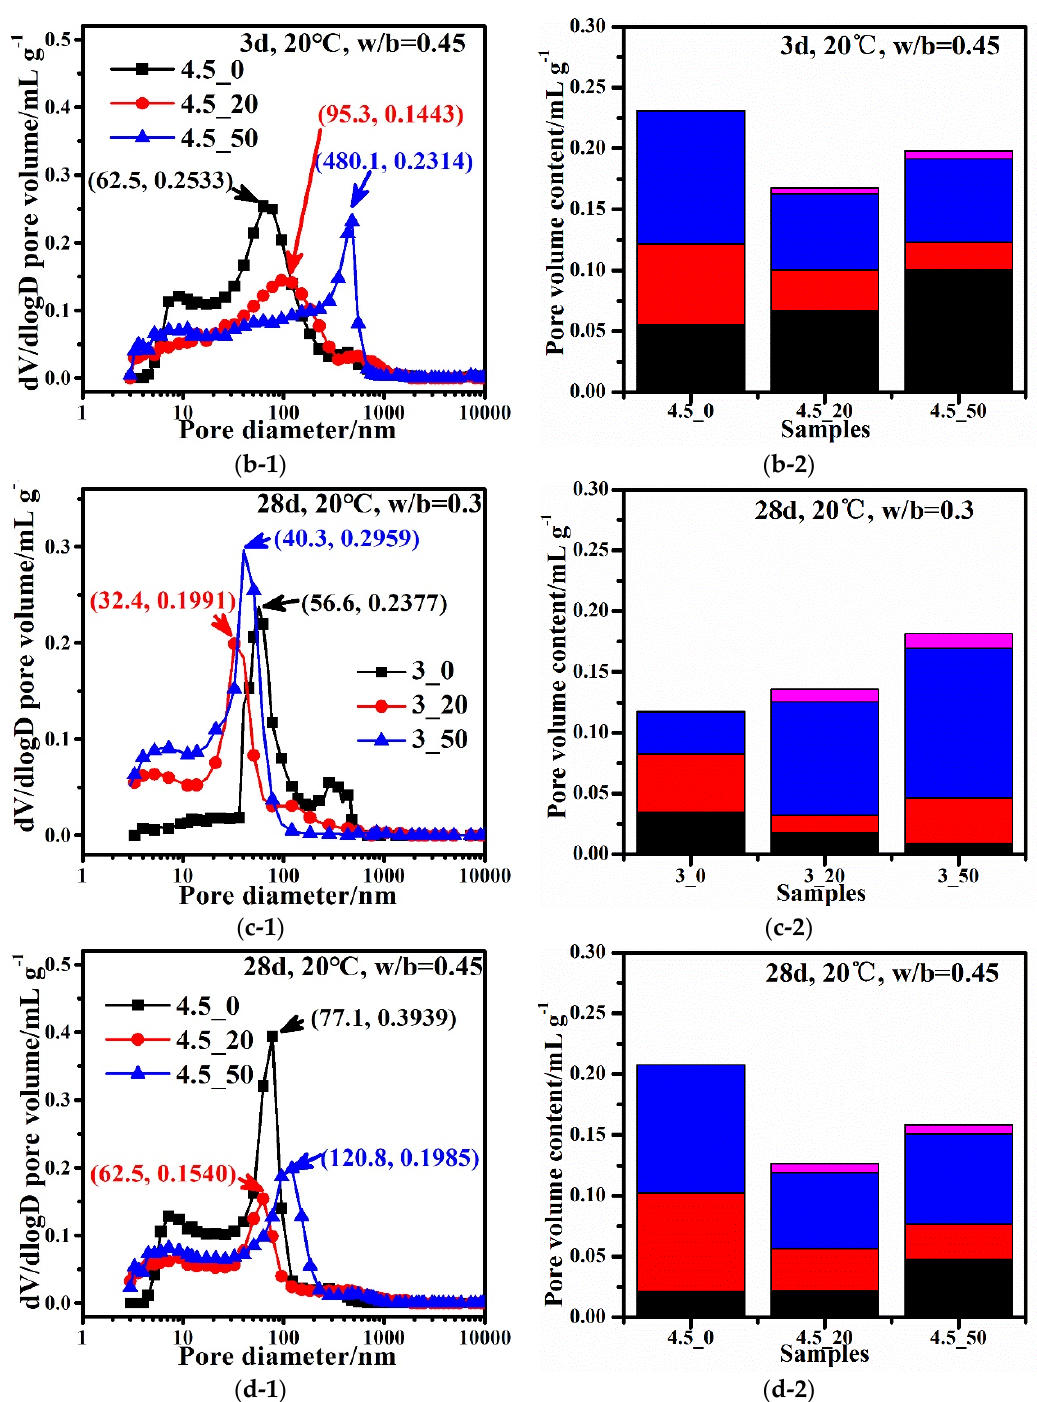
Figure 6. Pore size distribution and pore volume content of samples at different ages: ( a ) samples with a w/b of 0.3 and cured for 3 d, ( a-1 ) presents the differential intrusion curves of mercury of cement pastes with different contents of CZTP and various w/b, while ( a-2 ) illustrates the pore volume content of corresponding samples (the same with the following ( b-1 ), ( c-1 ), ( d-1 ) and ( b-2 ), ( c-2 ), ( d-2 )); ( b ) samples with a w/b of 0.45 and cured for 3 d; ( c ) samples with a w/b of 0.3 and cured for 28 d; ( d ) samples with a w/b of 0.45 and cured for 28 d.